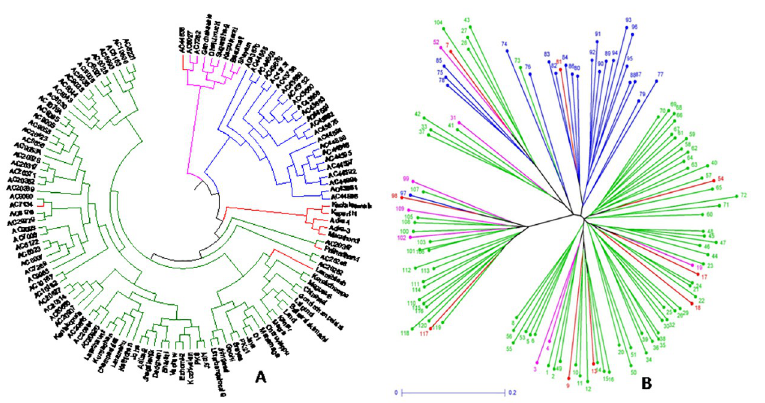
Fig 9. Tree constructed based on the genotyping results of 120 landraces using 136 SSR markers for depicting clustering pattern (A) UPGMA Unrooted tree (B) Neighbour-joining tree coloured on the basis of the sub- populations obtained from structure analysis at K = 3 (SP1: Blue; SP2: pink; SP3: green and Admix: red).